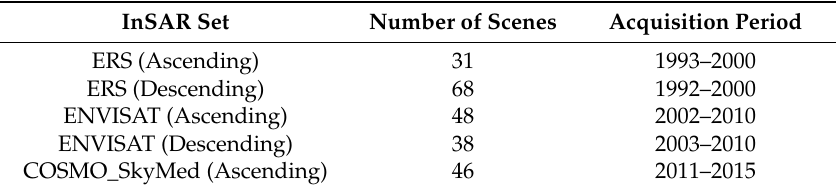
Table 1 . SAR datasets used in this work.